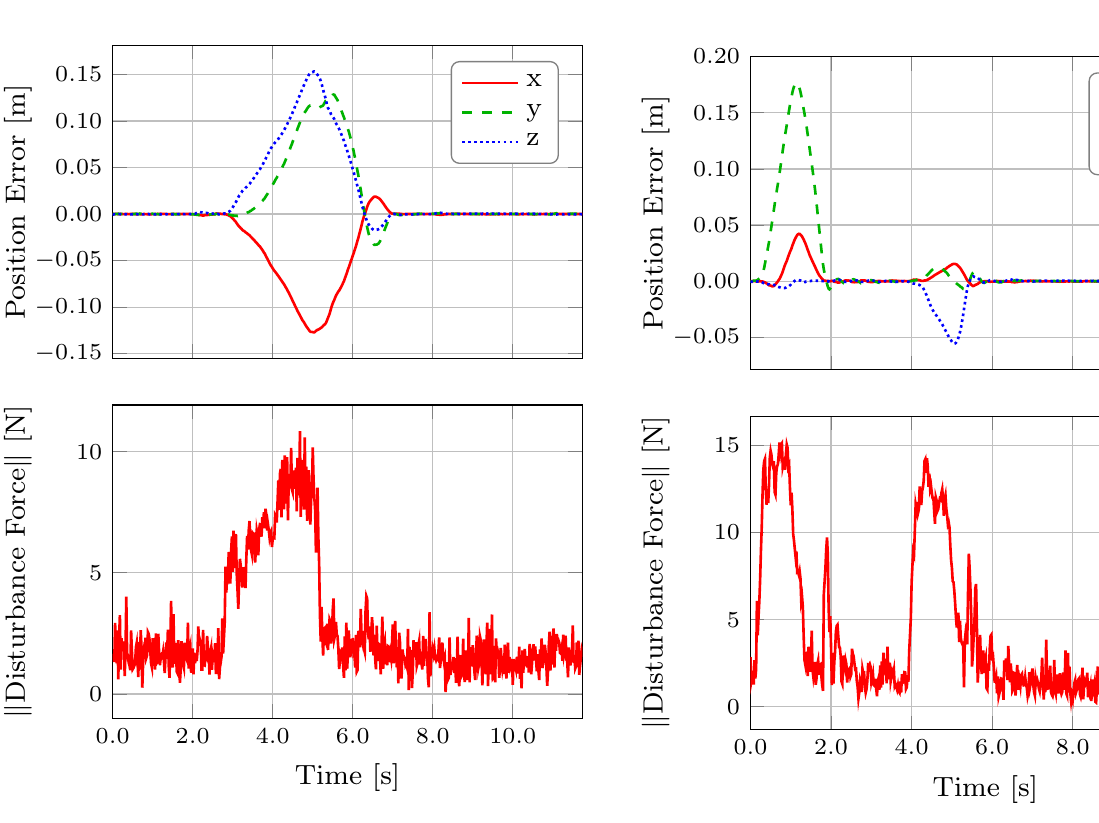
Fig. 16 Cartesian reference (solid) and measured position (dashed) of the end-effector of the COMPI manipulator when disturbed while moving along a reference trajectory with payload . Time indicated by arrows at every second